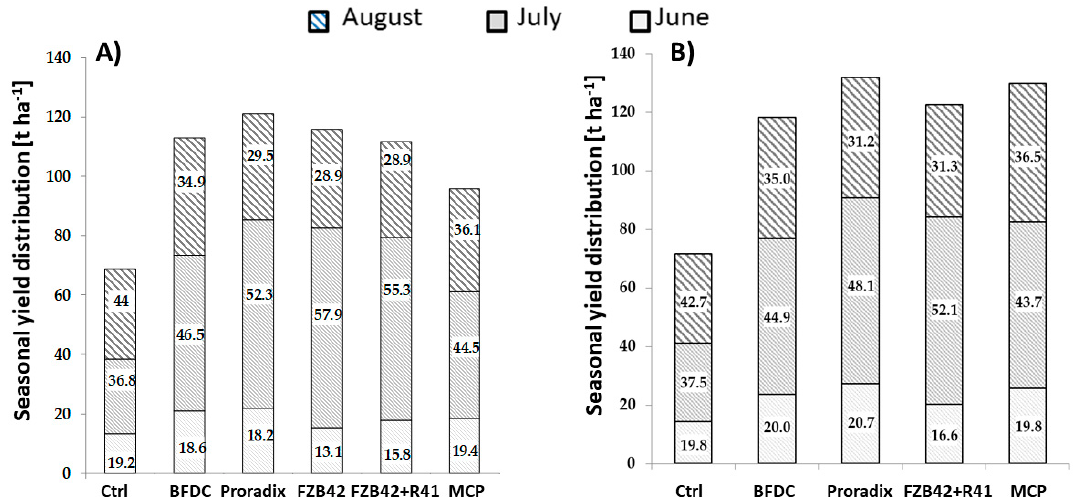
Figure 3. Seasonal yield share of tomato production over the whole harvesting period (June, July, and August) for different BS applications in Romania 2016 ( A ) and 2017 ( B ) (fruit yield in t ha − 1 ).